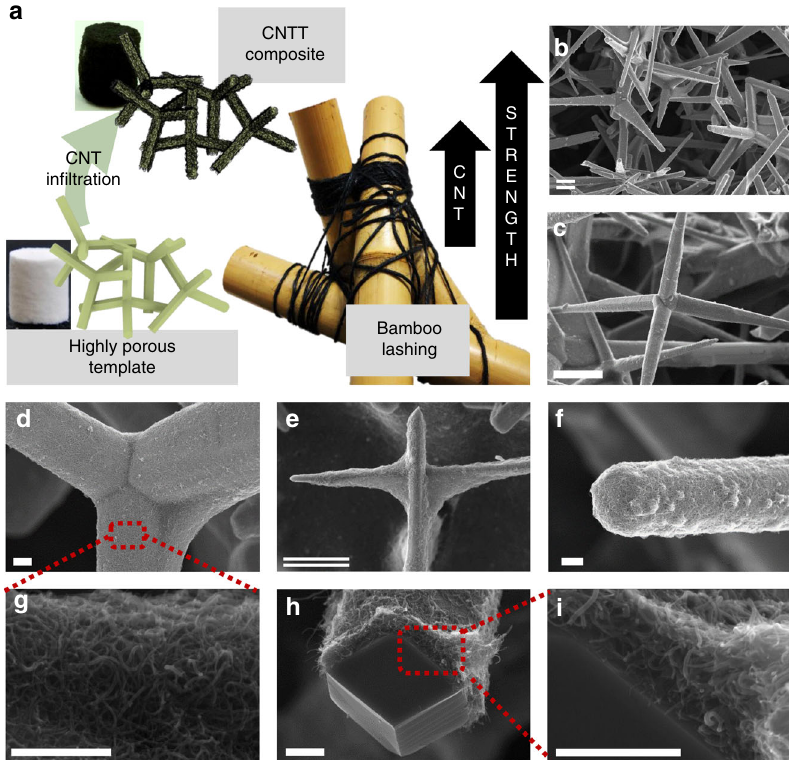
Fig. 1 Overview of the CNTT/t-ZnO composite structure. a Schematic representation of the fabrication process showing the highly porous (93%) ceramic network consisting of pre-sintered tetrapodal shaped ZnO microparticles ( V = 1.7 cm 3 ) before and after CNT in fi ltration. By adding CNTs to the network self-entangled CNT networks are formed leading to a high mechanical reinforcement effect, similar to traditional bamboo lashing; b , c SEM images of the ceramic network coated with a homogenous layer of self-entangled carbon nanotubes; d Detail of the CNT network around ZnO tetrapod central joint; e Detail of CNT network around tetrapods junction; f , g High magni fi cation SEM images showing that the CNTs form self-entangled layers on the ceramic template; h , i Self-entangled CNT layer on a broken tetrapod arm, revealing the thickness of the coated CNT layer. (Scale bars: single: 1 µ m, double: 10 µ